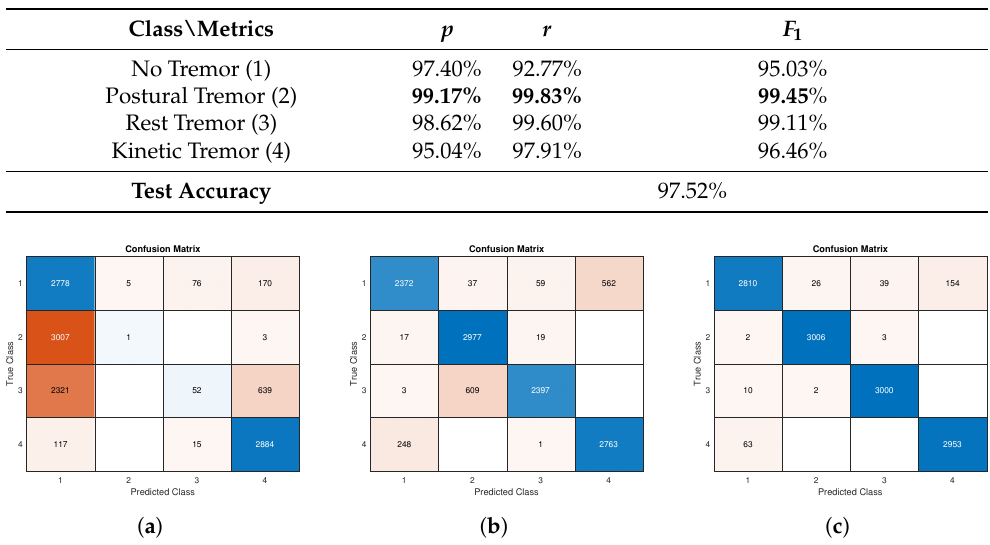
Table 9. Classification performance results computed on acceleration and gyroscope data: in the training phase and test phase, 8 bit sensors with 10% worse noise were used (worst/worst).